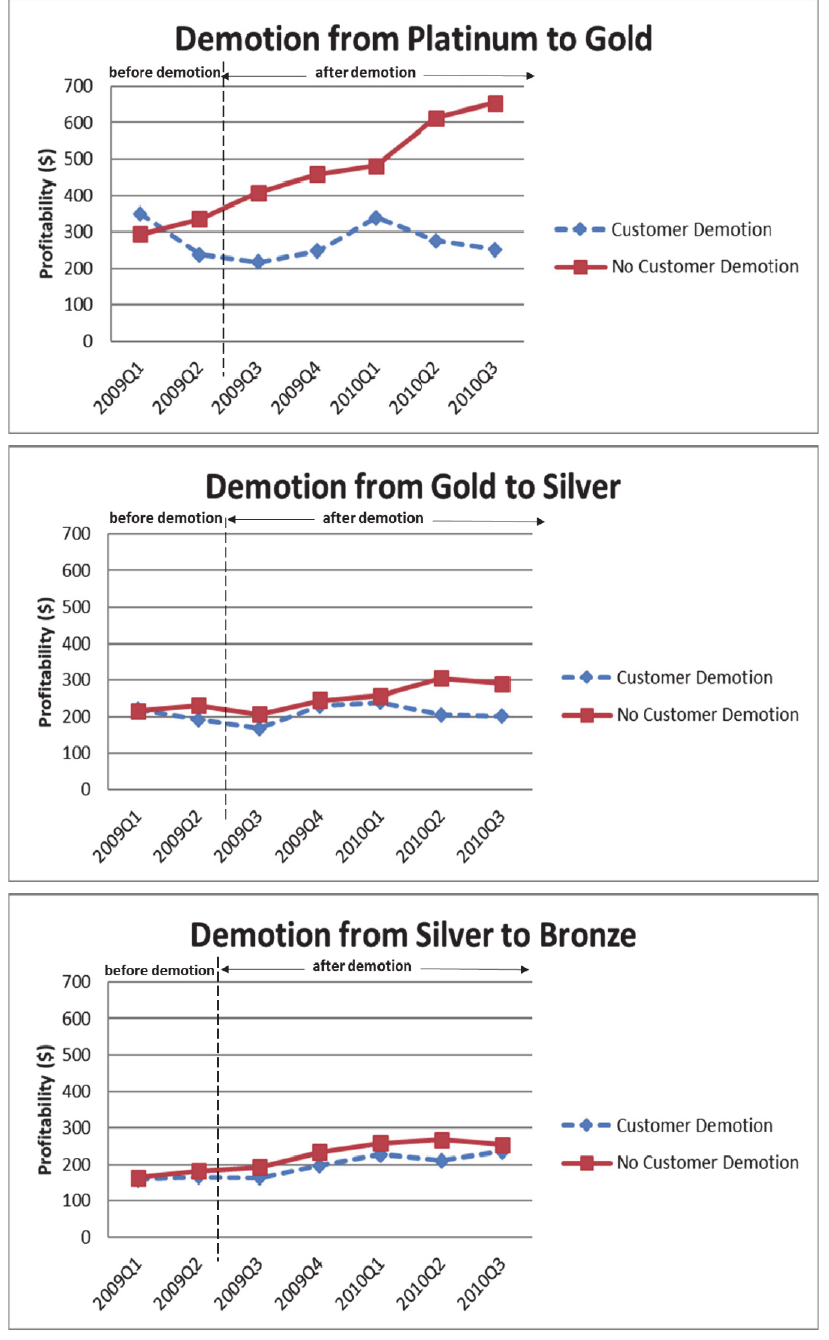
<Figure 2> Customer Profitability Comparison between Demoted and Control Groups on a Status